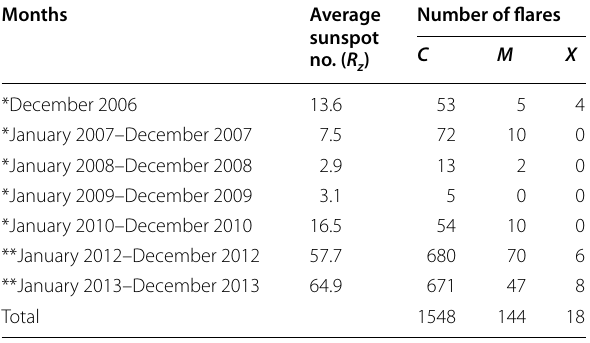
Table 1 Occurrence of solar flares of different classes ( C , M , X ) as observed by GOES for the periods of data analy- sis (*low solar activity, **moderate solar activity) together with the average sunspot numbers for each year Months Average